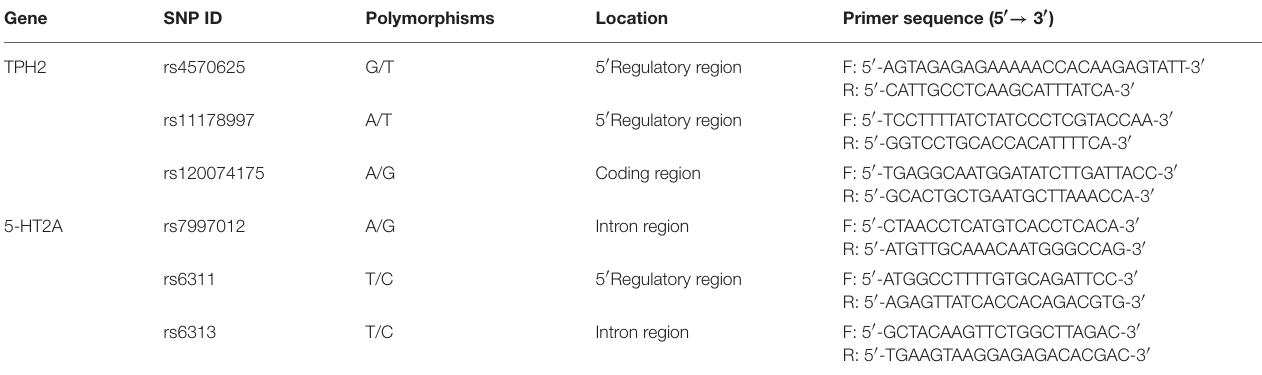
TABLE 1 | The primers sequence for SNPs of TPH2 and 5-HT2A.